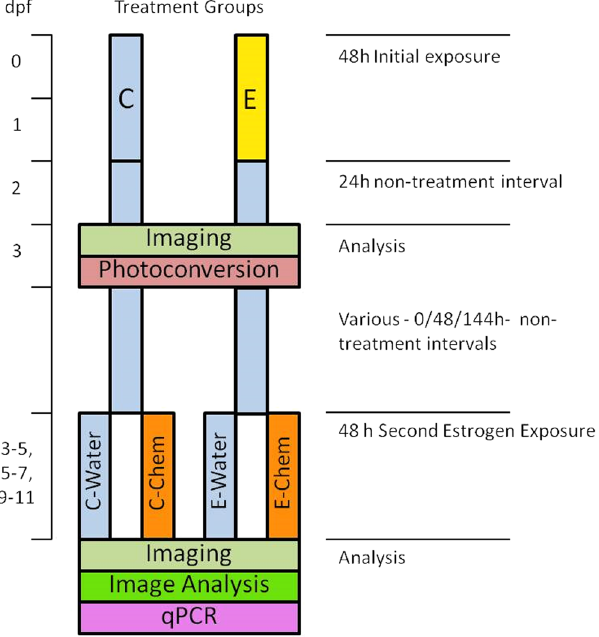
Figure 6. Exposure Protocol Outline. ERE-Kaede-Casper embryos were initially separated into 48 h control ( C ) and EE2 (10 ng/L) initial-exposure ( E ) groups. After a subsequent 24 h non-exposure period, larvae were imaged and Kaede expression underwent photoconvertion (green to red fluorescence, 3 dpf). Various intervals of non-exposure were then adopted before a second estrogen exposure was conducted. Larvae from the